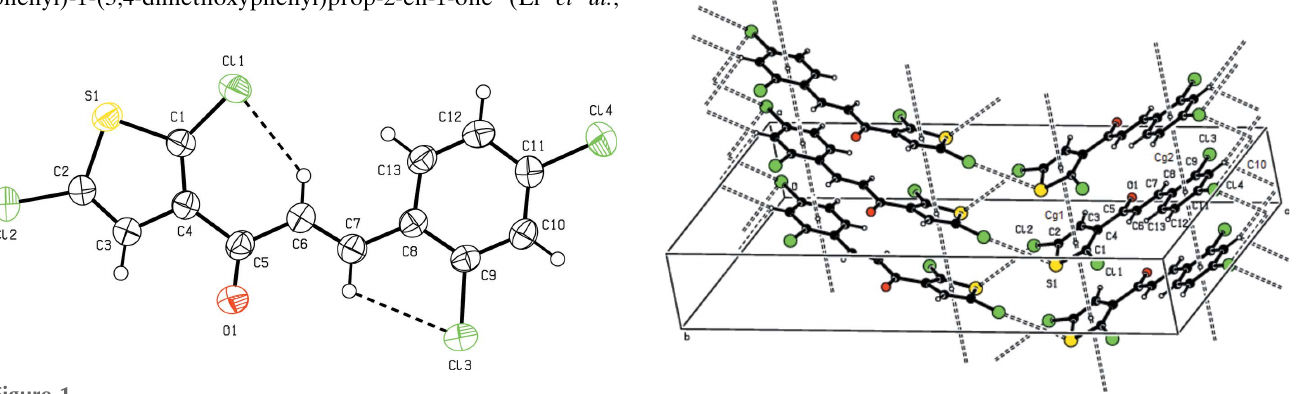
Figure 2 A view of the offset face-to-face (cid:2) -stacking in the title compound, with the thick dashed lines indicating centroid-to-centroid interactions. The Cl (cid:3)(cid:3)(cid:3) H and Cl (cid:3)(cid:3)(cid:3) S interactions are also shown as dashed lines.